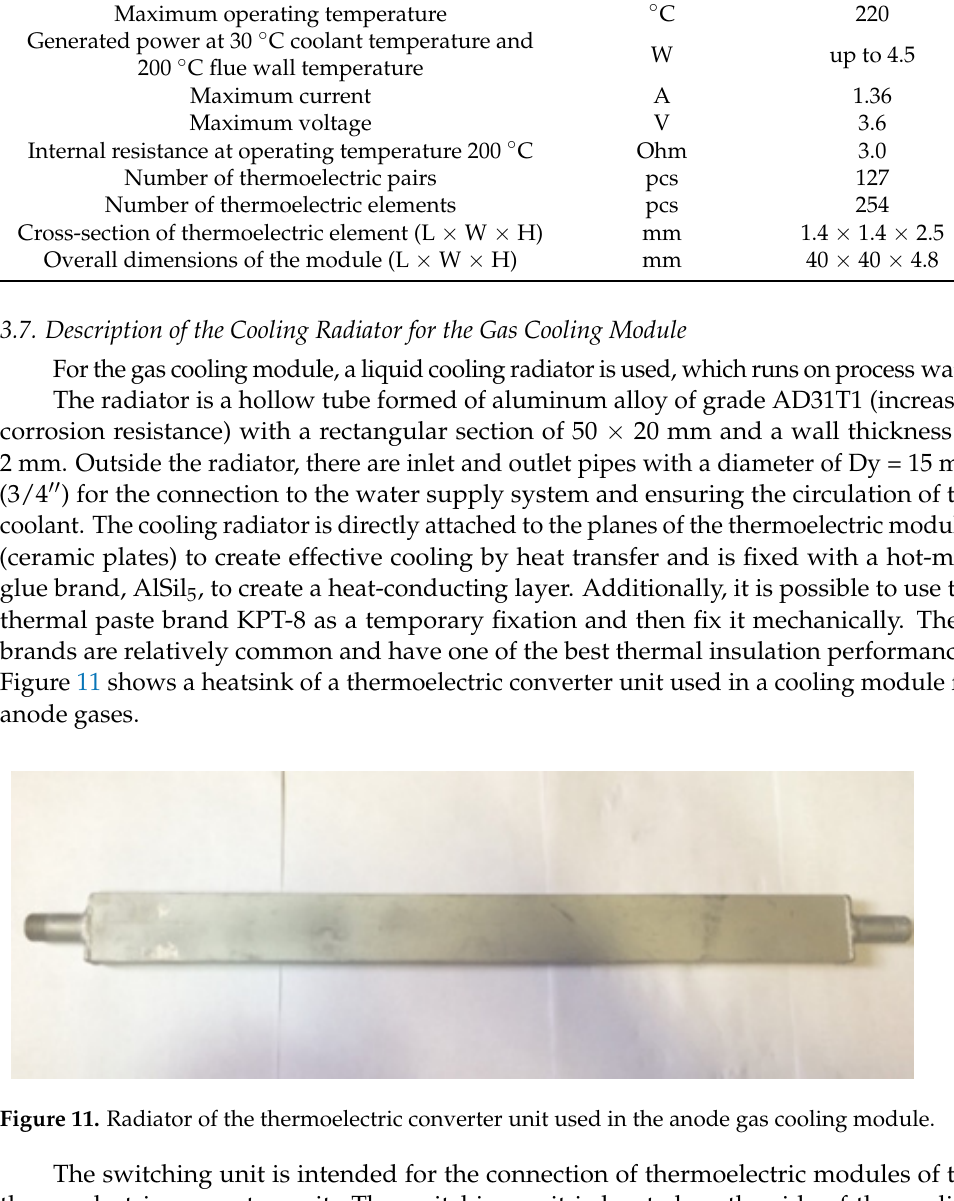
ample, the modules are connected in series (Figure 12).